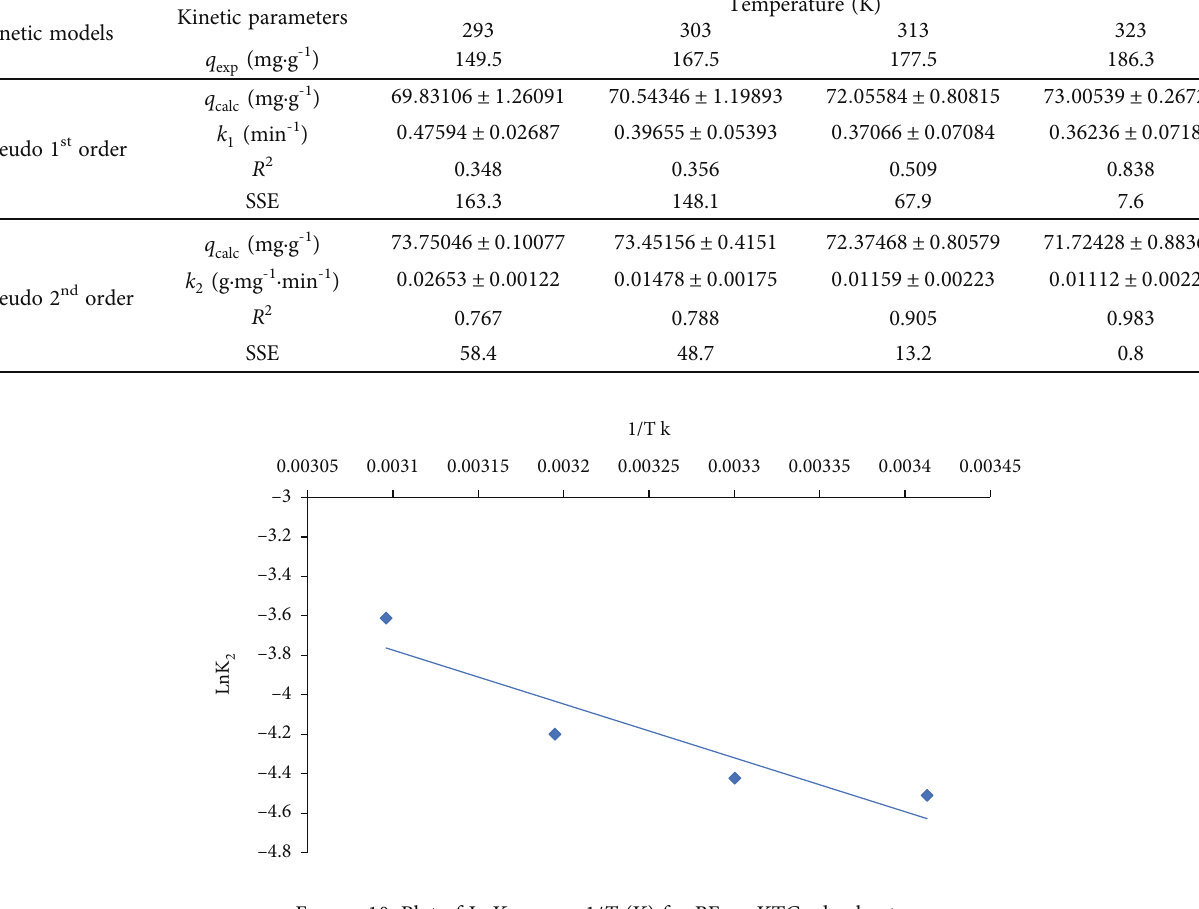
versus 1/ T (K) for BF on KTC 2